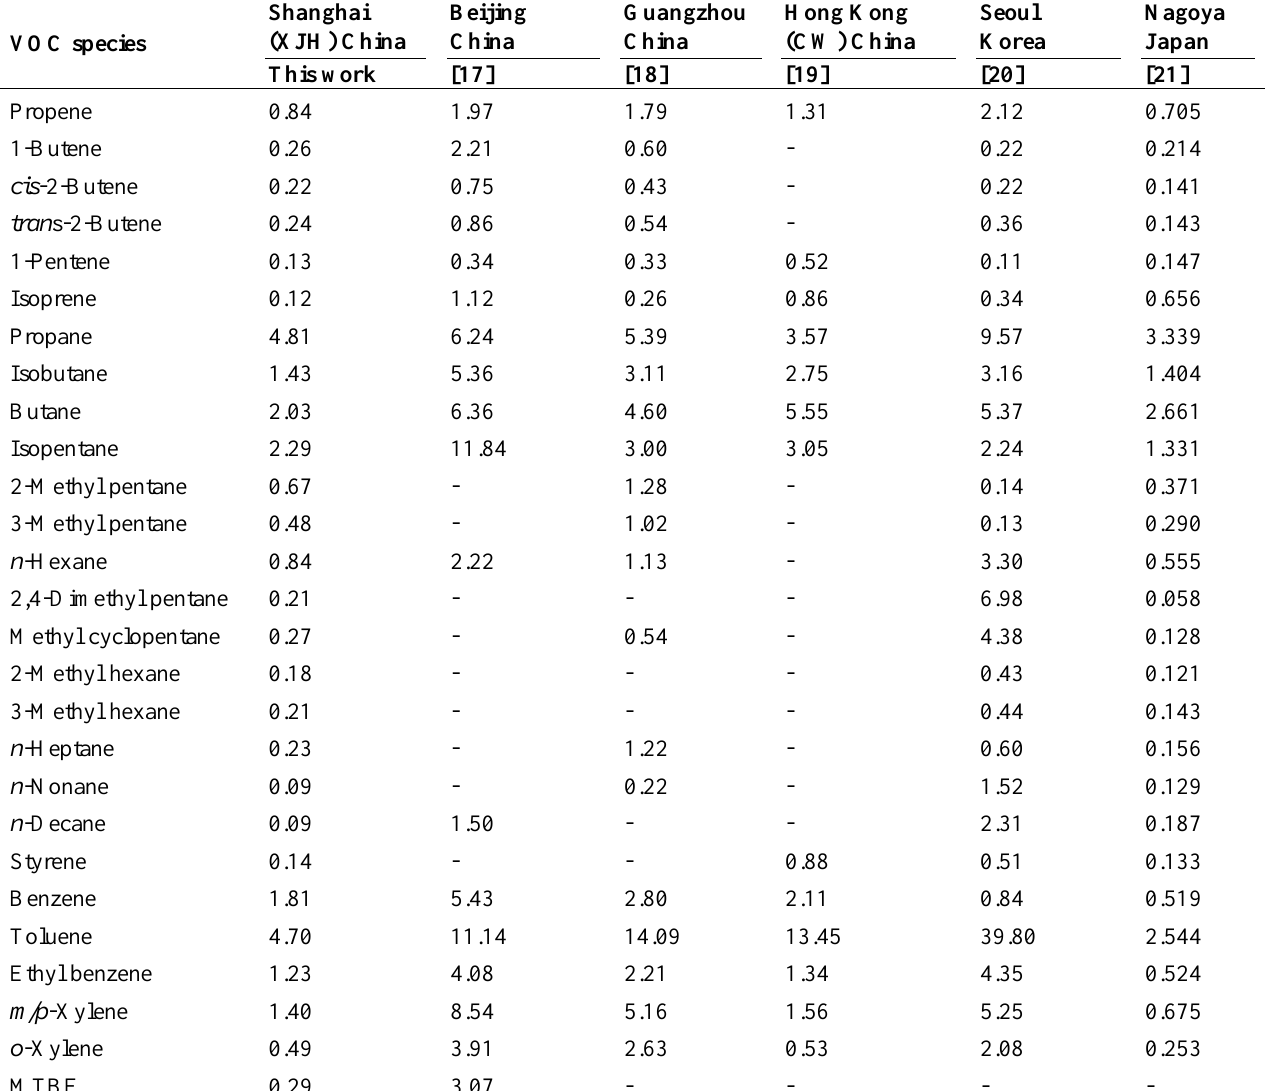
Table 4. Measured VOC concentrations (ppbv) in different urban